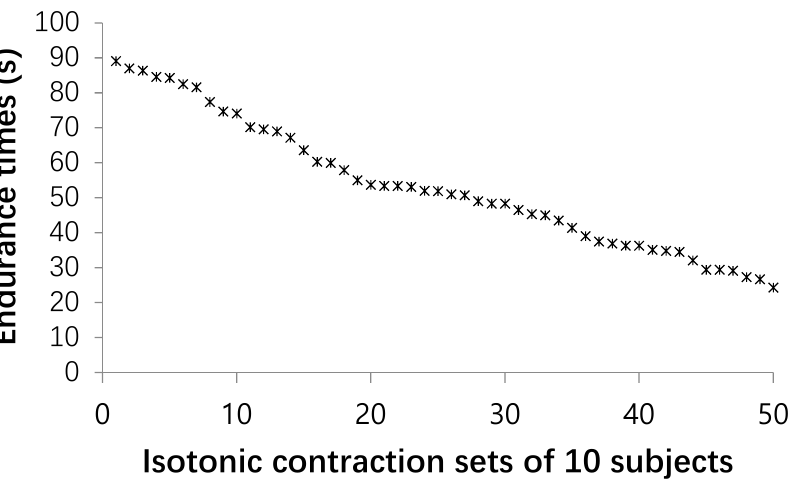
Figure 7. Endurance times in descending order.